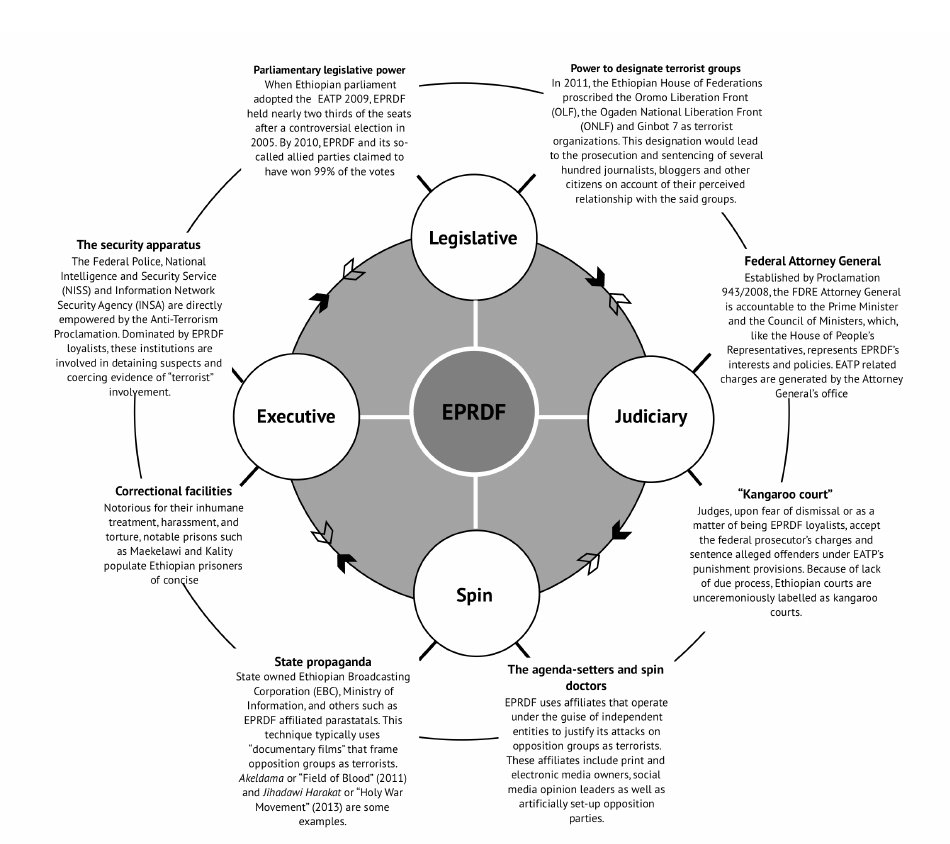
Fig. 1: The neopatrimonial interlocks of the Ethiopian Anti-Terrorism